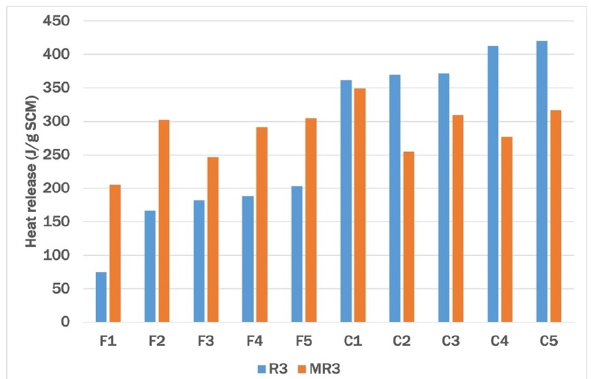
Figure 2. Heat release of unconventional fly ashes using the R 3 and modified R 3 tests (unpublished